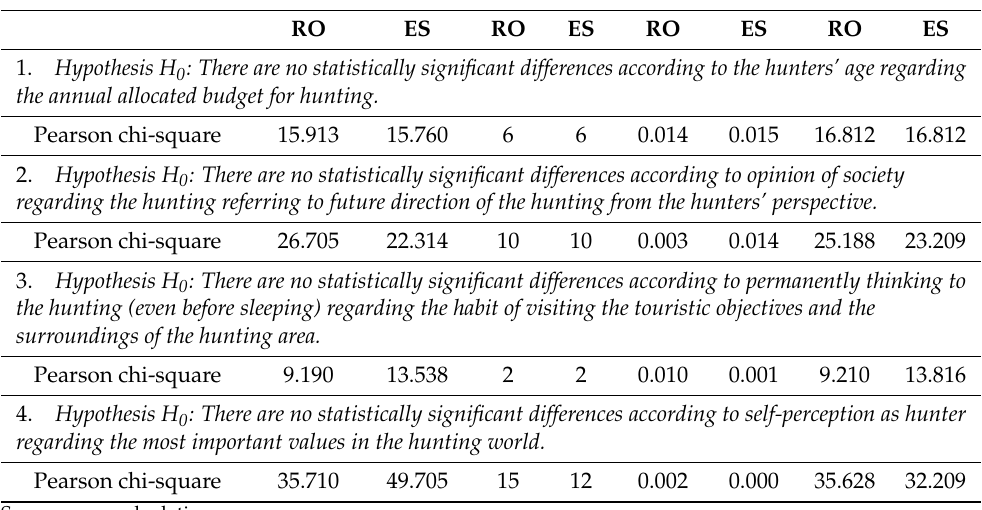
Asymp. Sig. χ 2 Theoretical (2-Sided)